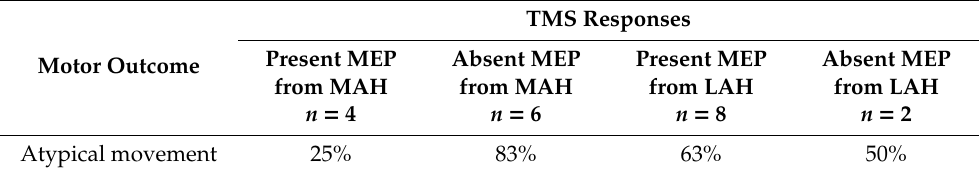
Table 4. Atypical movement across MEP outcome from TMS of each hemisphere. TMS Responses Present MEP Absent MEP Present MEP Absent MEP Motor Outcome from MAH from MAH from LAH from LAH n = 4 n = 6 n = 8 n = 2 Atypical movement